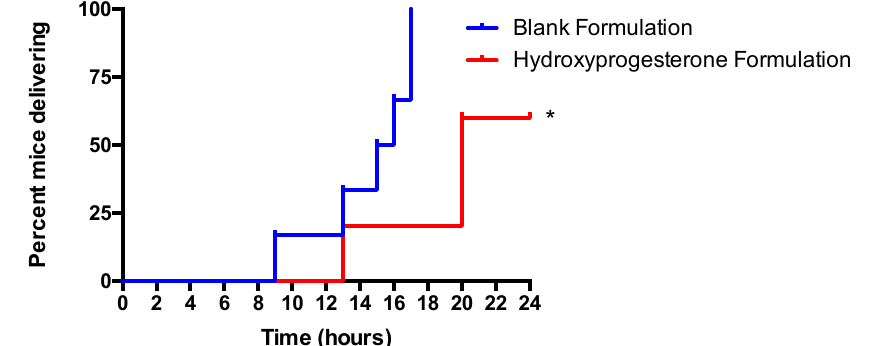
Figure 5. 17P SNEDDS reduces the incidence of preterm birth and delays labor and delivery in LPS-stimulated timed pregnant E 15.5 mice. Mice injected with 25 mg / kg of LPS to induce PTB were treated with vaginal administration of the17P formulation. All mice were observed for PTB for a period of 24 h. 17P significantly reduced the percentage of mice delivering over time. * p < 0.05 Mantel–Cox Test.